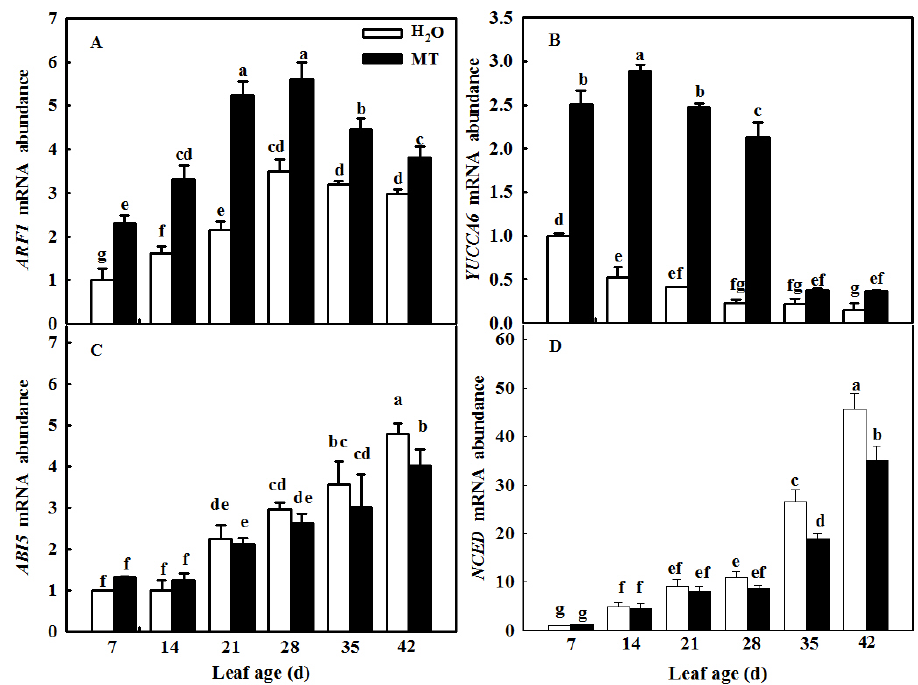
Figure 8. The effect of exogenous MT on IAA-/ABA-related gene mRNA abundance in different age leaves of cucumber plants in a solar greenhouse. ( A ) ARF1 mRNA abundance; ( B ) YUCCA6 mRNA abundance; ( C ) ABI5 mRNA abundance; ( D ) NCED mRNA abundance. At the three-leaf stage, the new leaf at the top was labeled 0 days and then labeled at 7, 14, 21, 28, 35, and 42 days. Meanwhile, cucumber plants were sprayed with 100 μ mol L − 1 MT every 7 days, and plants treated with H 2 O were the control. The different leaf-age leaves were sampled for gene mRNA abundance determination. All values shown are mean ± SD ( n = 3). a, b, c, d, e, f, and g indicate that mean values are significantly different among samples ( p < 0.05).